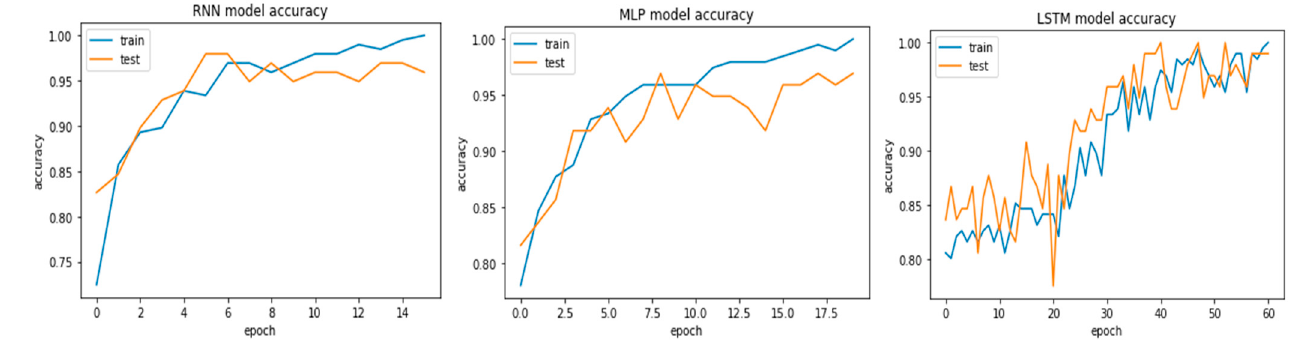
Figure 6. Testing and training accuracy of RNN (left), MLP (middle), and LSTM (right).